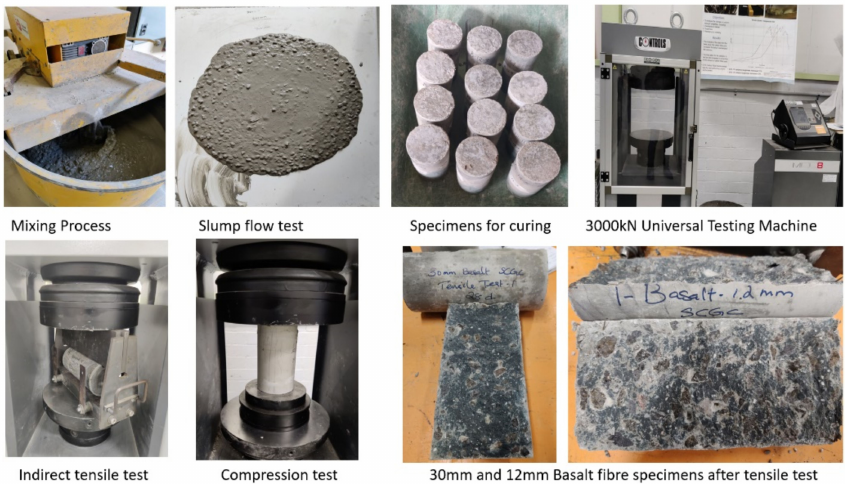
Figure 2. Workability and mechanical tests on test